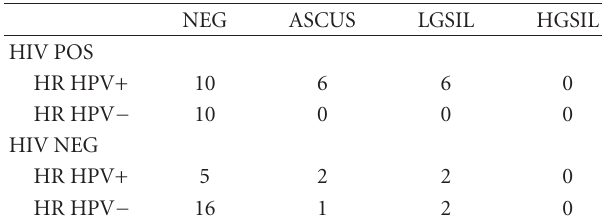
Table 3: Thin prep